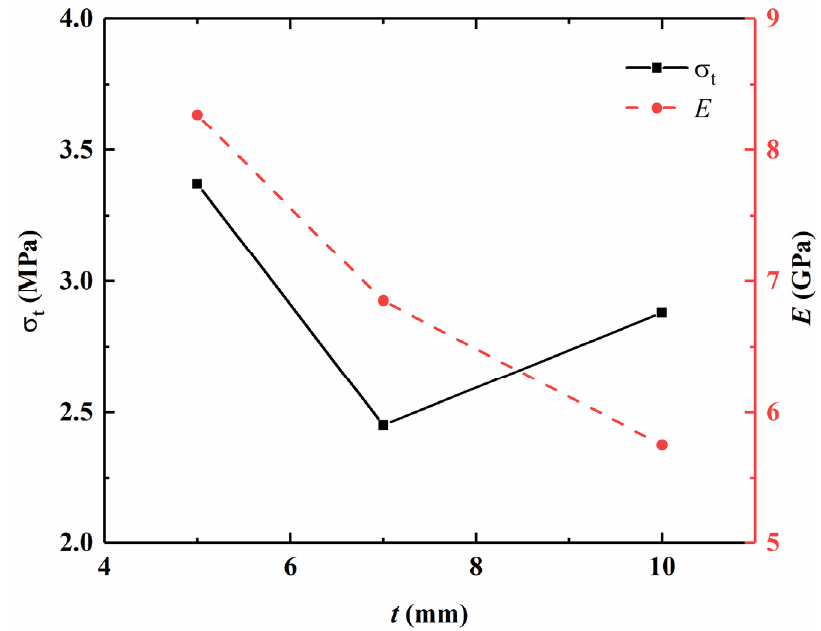
Figure 6. Variation of tensile stress and elasticity modulus with different cutting depths.